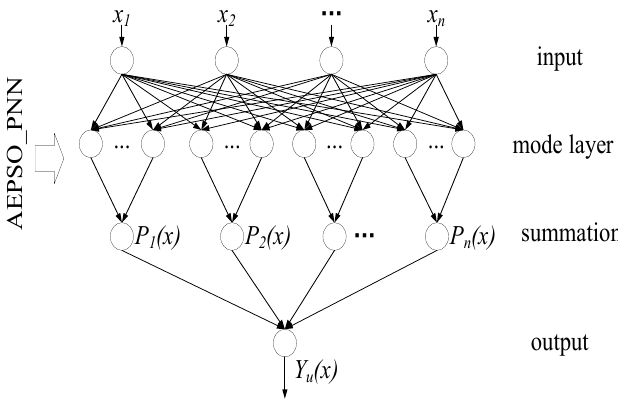
Figure 5. Adaptive evolution particle swarm optimization probabilistic neural network (AEPSO_PNN) network structure diagram.